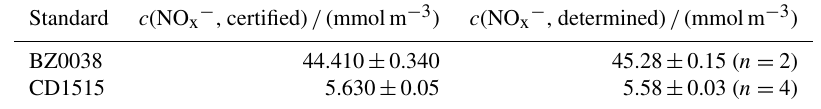
Table A1. Summary of NO x − concentrations in calibration